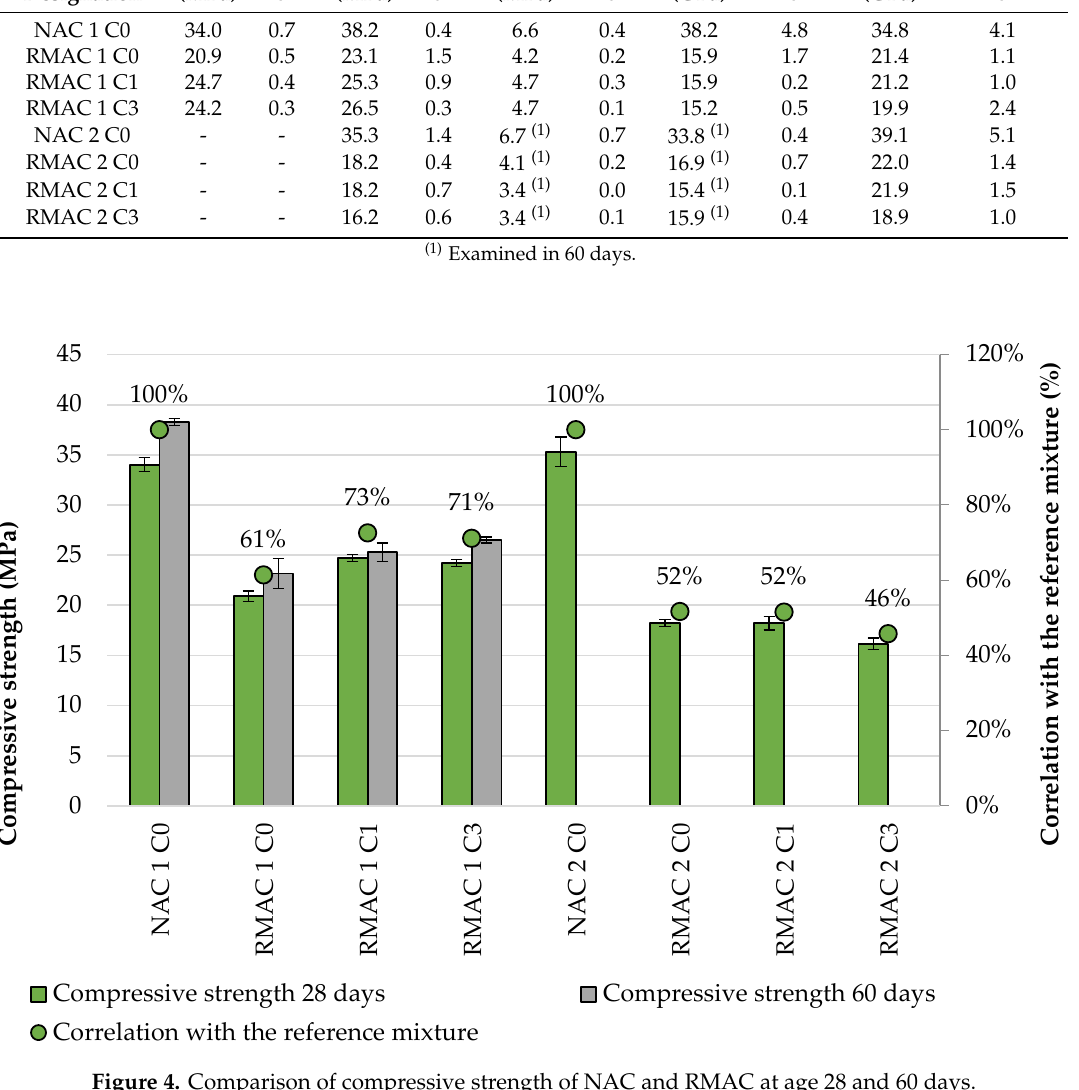
Figure 4. Comparison of compressive strength of NAC and RMAC at age 28 and 60 days.